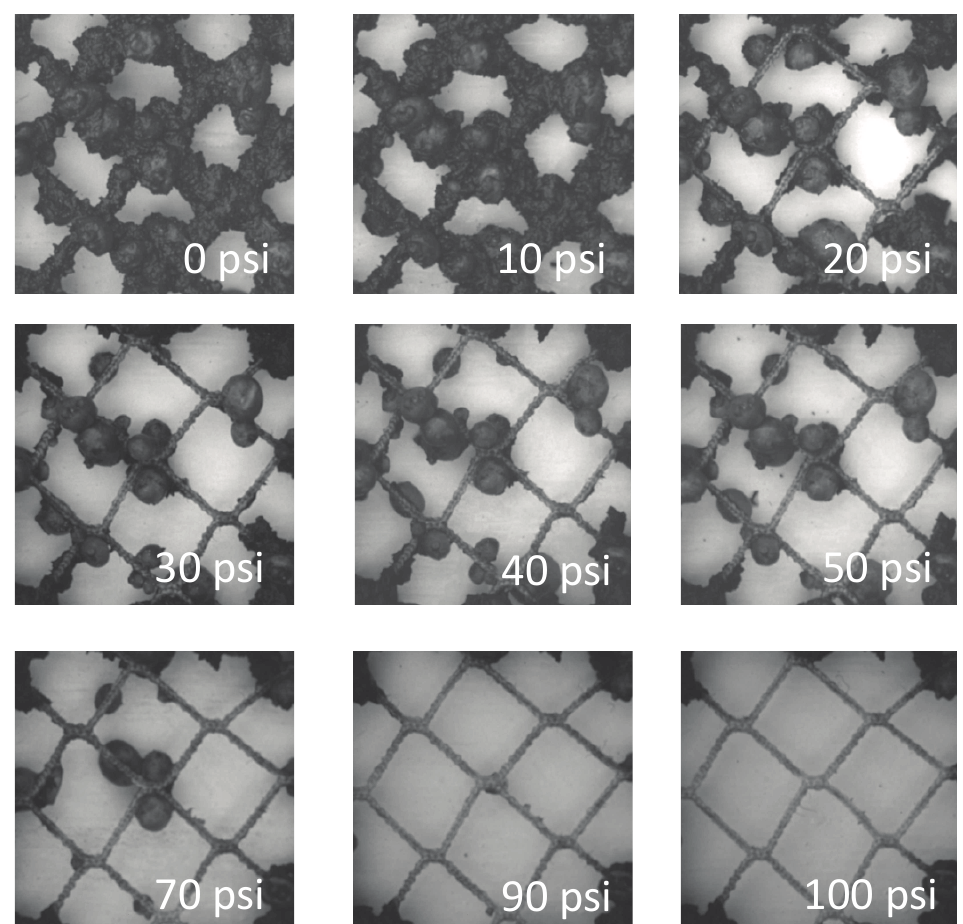
Figure 4. Fouling removal from the uncoated net using the